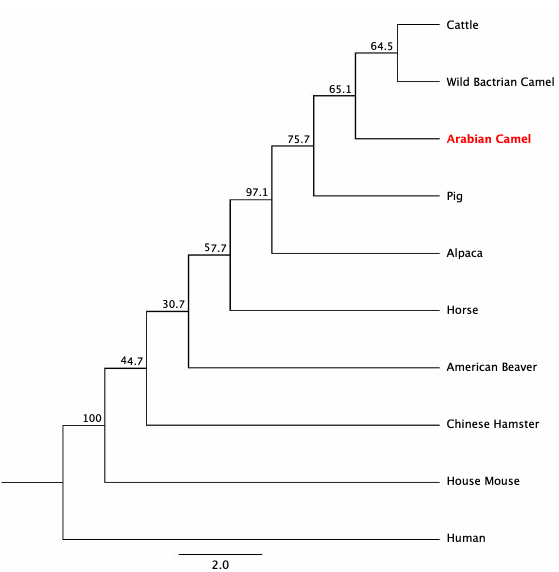
Figure 9. The phylogenetic tree shows the relationship of the cLin-28 protein with protein sequences from other species. The maximum likelihood tree is based on complete coding sequences. The values at nodes are bootstrapping 30% obtained from 1000-fold data re-sampling.